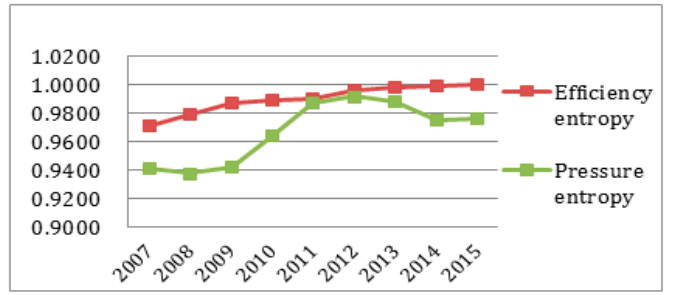
Figure 5. Entropy flow change in the economic subsystem. Int. J. Environ. Res. Public Health 2017 , 14 , 1219